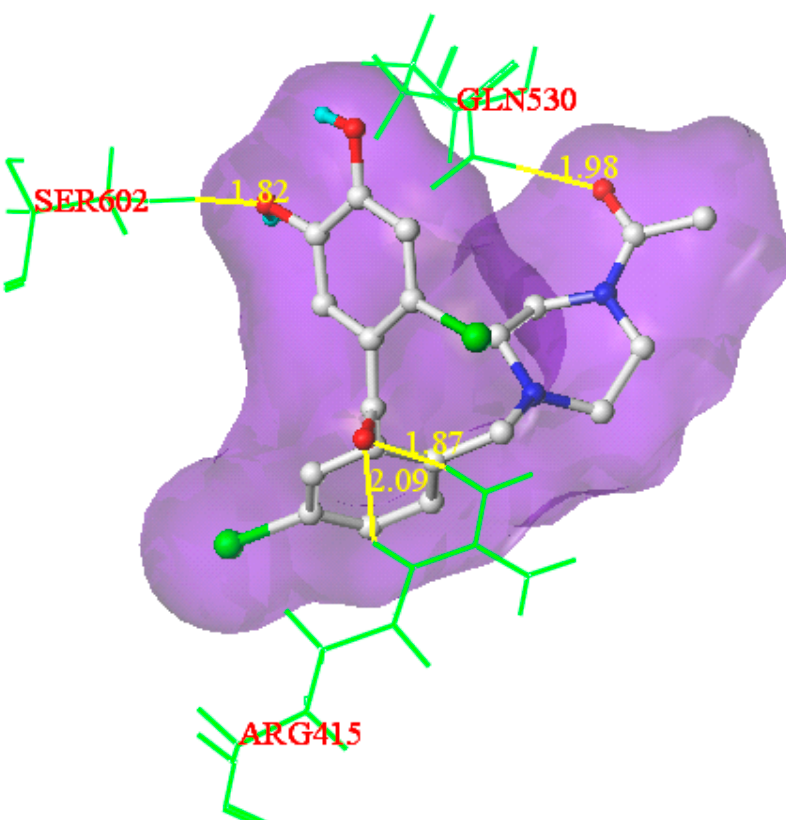
Figure 3. The binding modes of compound 22b with Keap1 Kelch domain showing interacting amino acids and H-bonds. (Green shows the interacting amino acid residues, yellow dotted lines show the formed hydrogen bonds.)